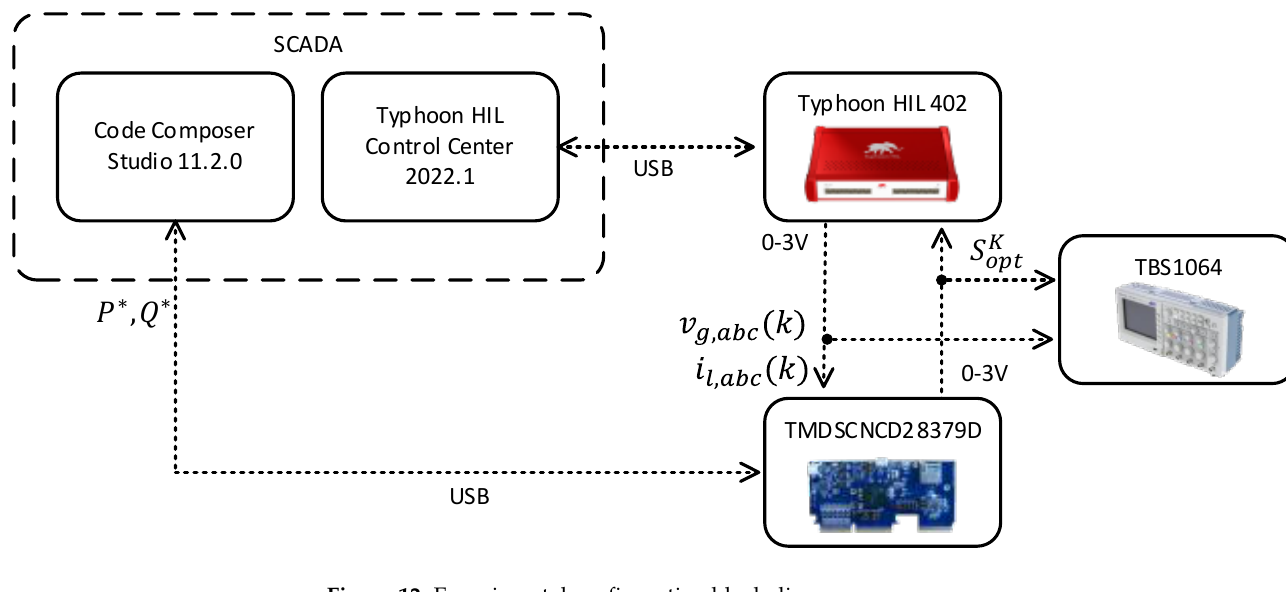
Figure 12. Experimental configuration block diagram.